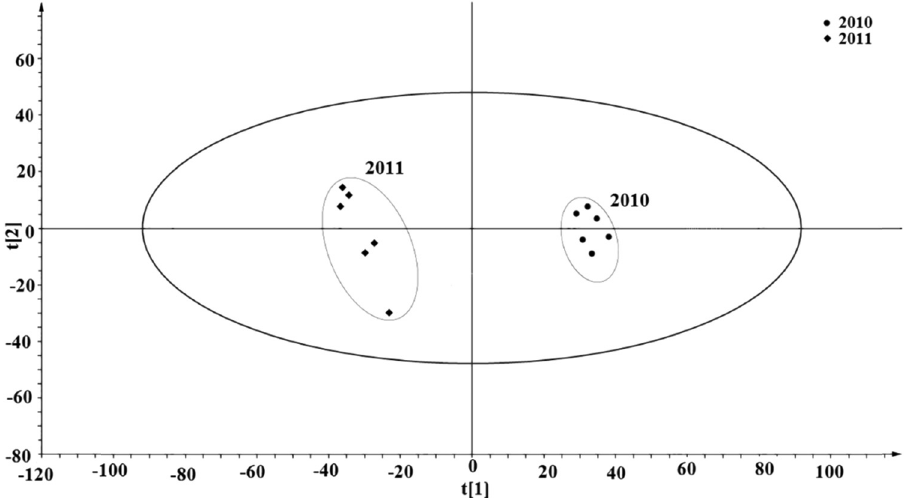
Figure 12: PLS - DA score plot chart from 1 H NMR spectra of 2010 and 2011 vintage Cabernet Sauvignon